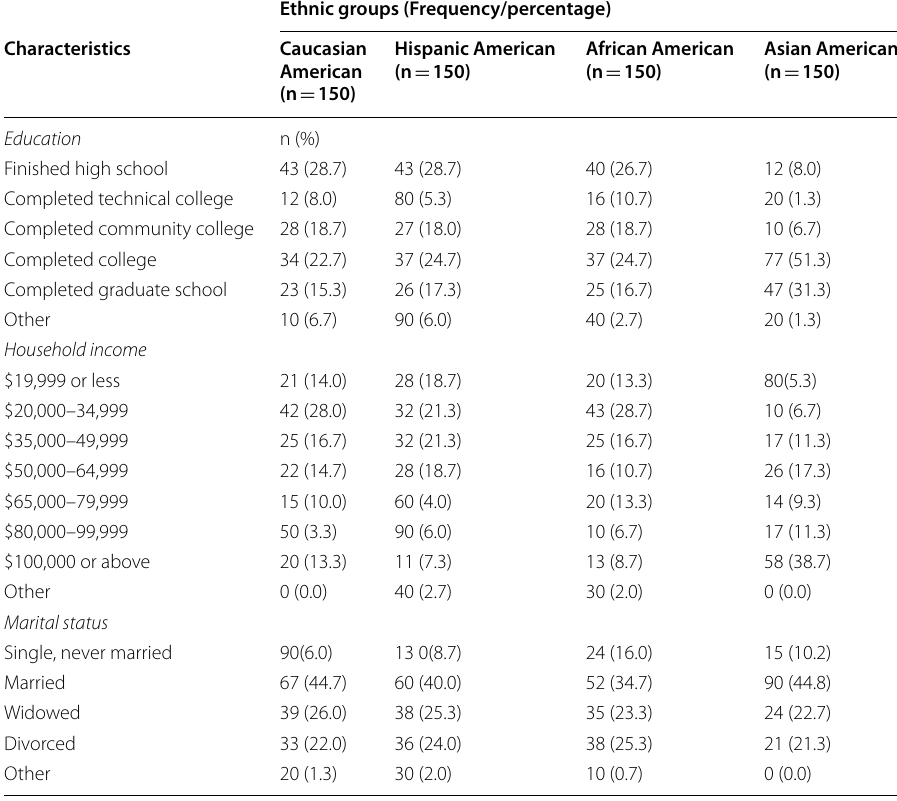
Table 1 Demographic information